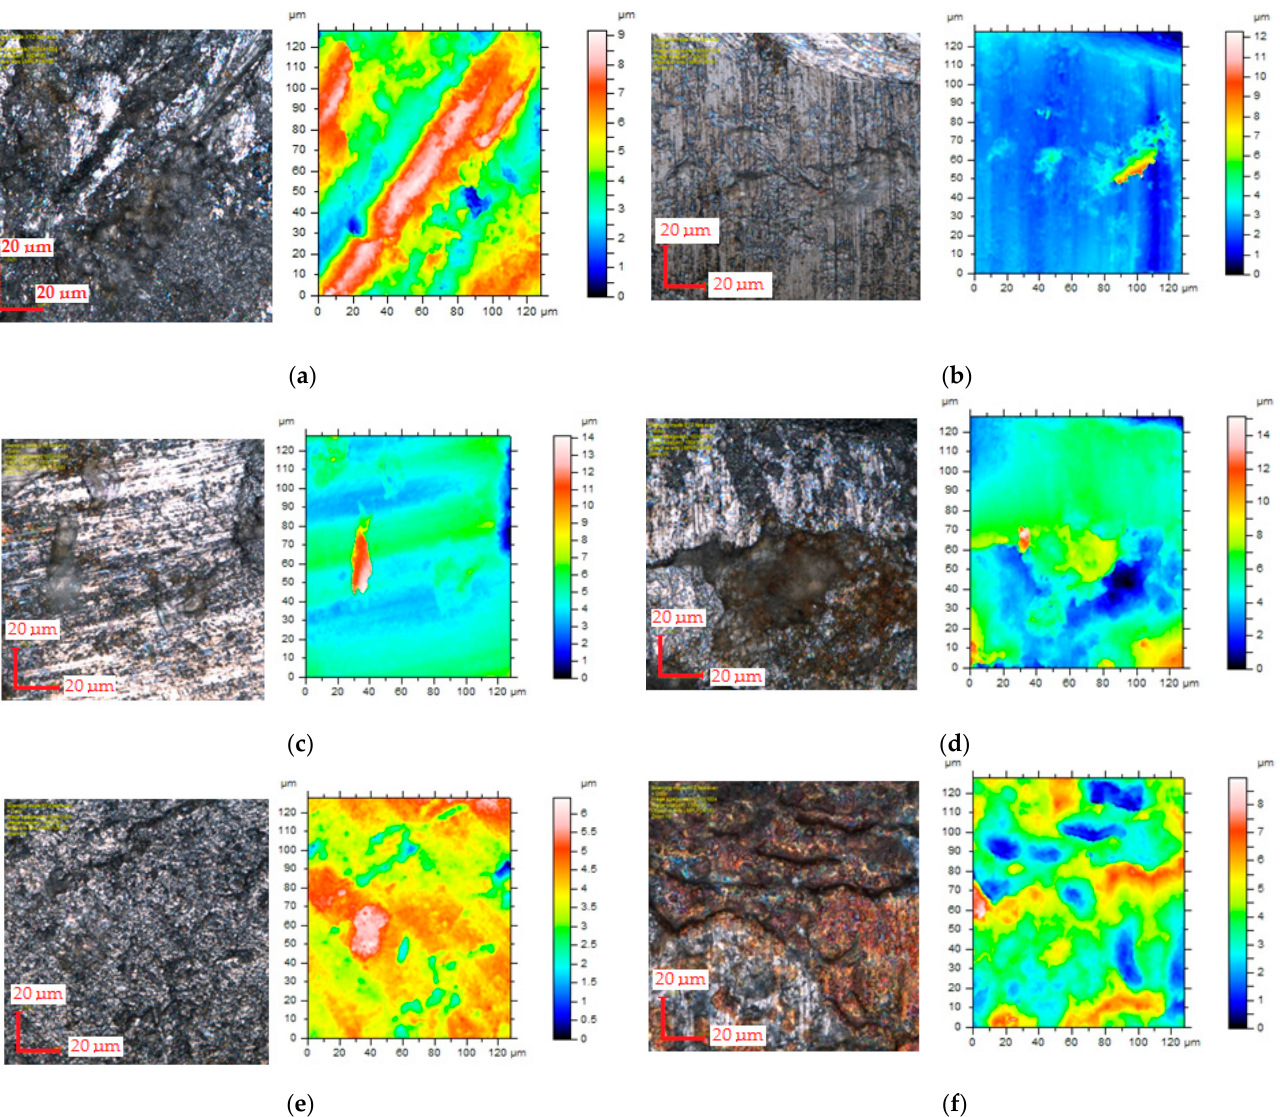
Figure 13. Influence of selected process parameters on contour maps of burnished areas of cut surfaces: ( a ) v 2 = 3 m/min, c h = 0.04 mm, α = 30°; ( b ) v 2 = 13 m/min, c h = 0.04 mm, α = 30°; ( c ) v 2 = 18 m/min, c h = 0.04 mm, α = 30°; ( d ) v 2 = 3 m/min, c h = 0.08 mm, α = 30°; ( e ) v 2 = 13 m/min, c h = 0.08 mm, α = 30°; ( f ) v 2 = 18 m/min, c h = 0.08 mm, α = 30°.